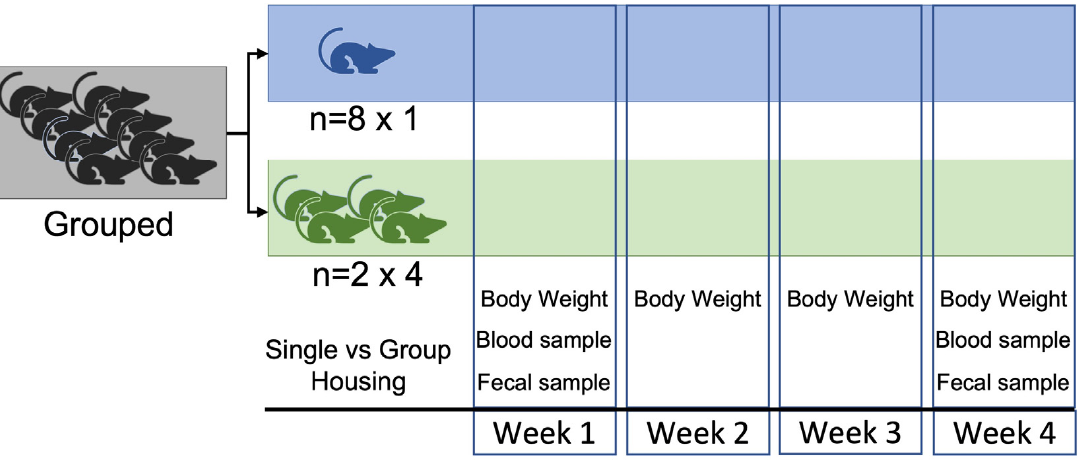
Figure 1. Experimental procedure.